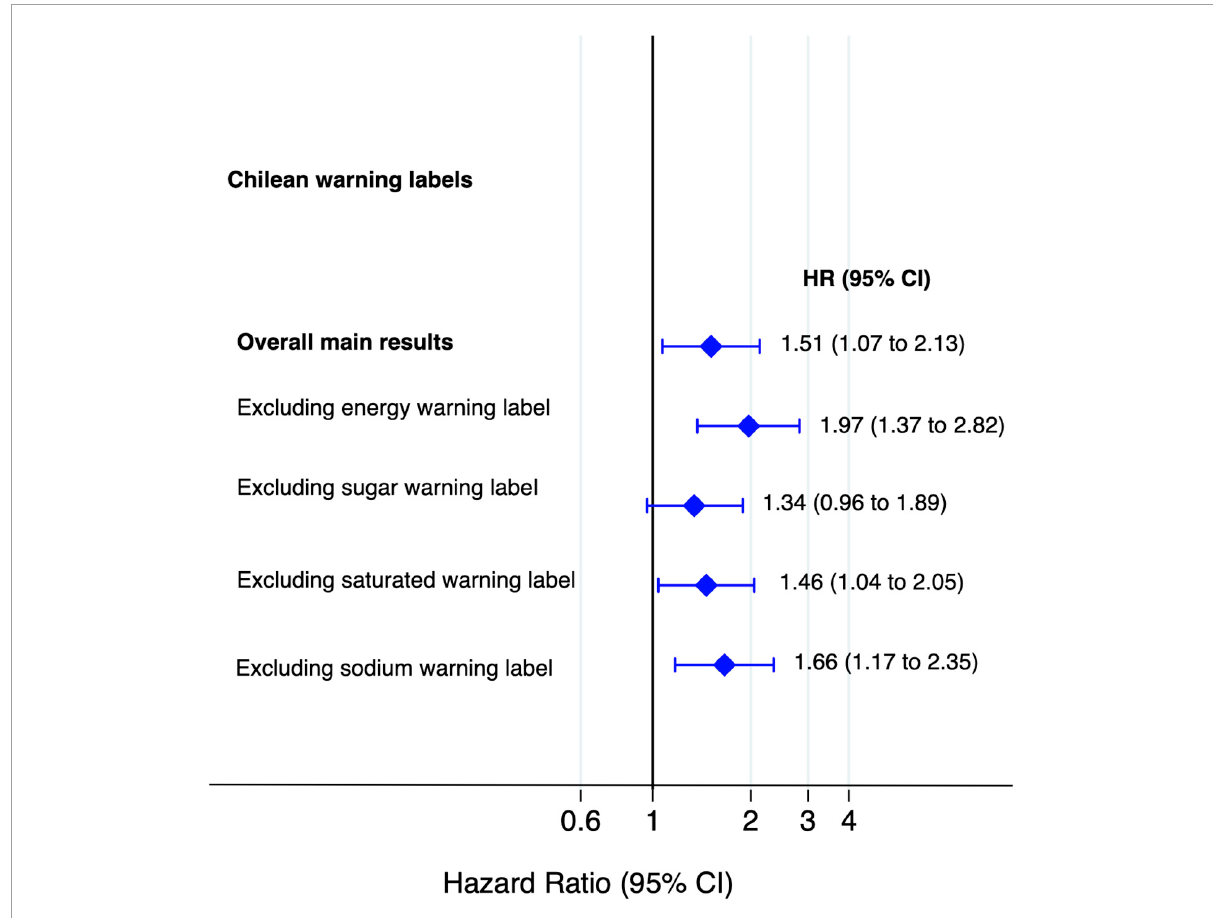
FIGURE6 Association between food consumption with Chilean warning label score and mortality and excluding one warning label at time (multivariable-adjusted HR and 95% CI for the highest vs. lowest quartile).